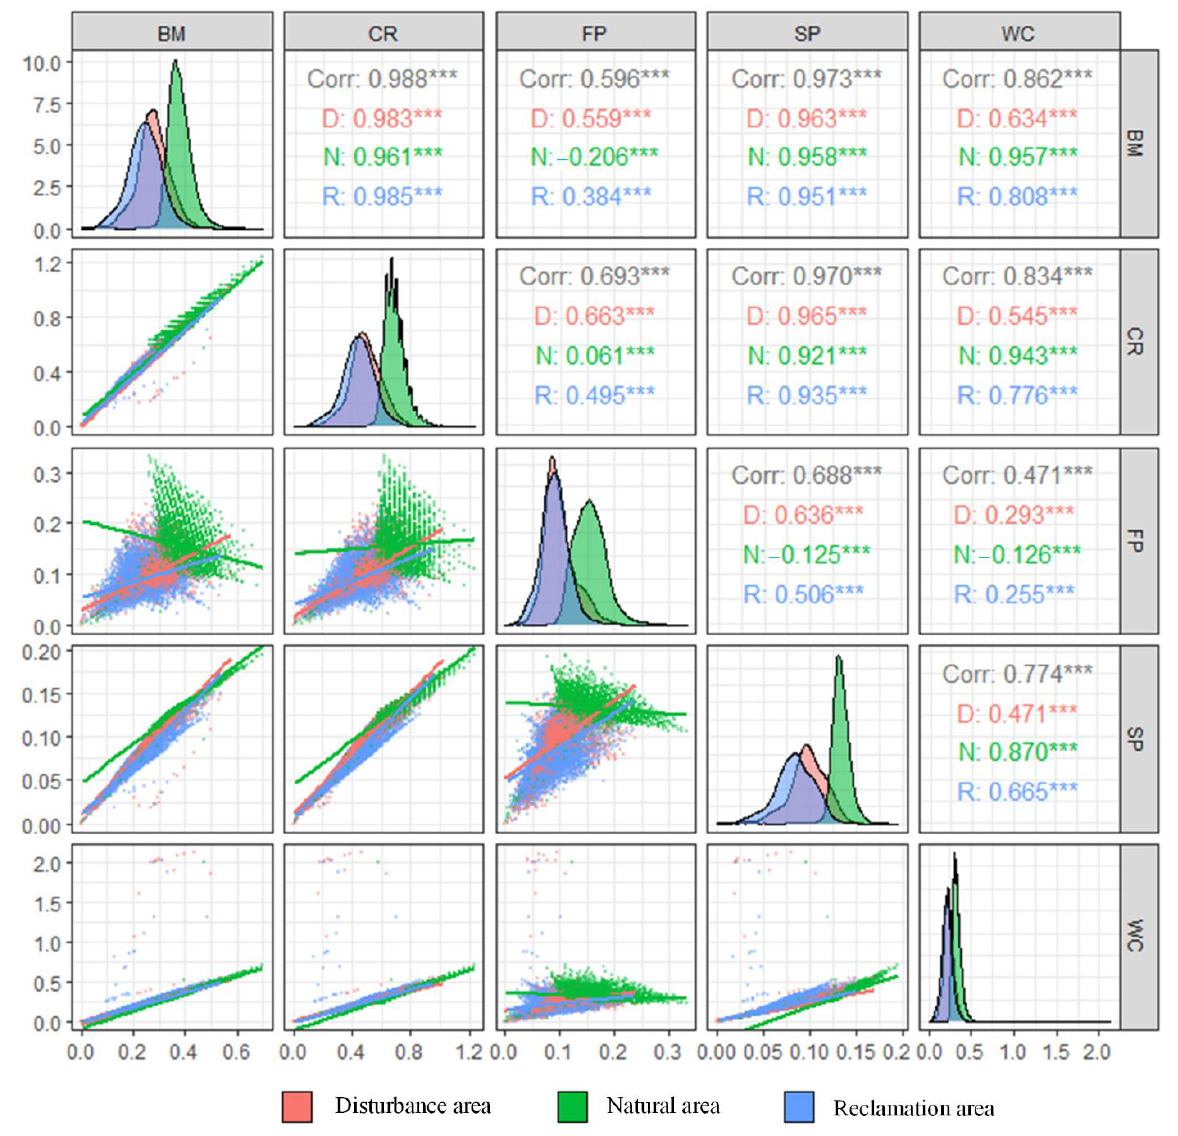
Figure 10. Pixel-scale correlations between pairwise ecosystem services during 1986 – 2021. *** Sig- nificantly correlated at the 0.001